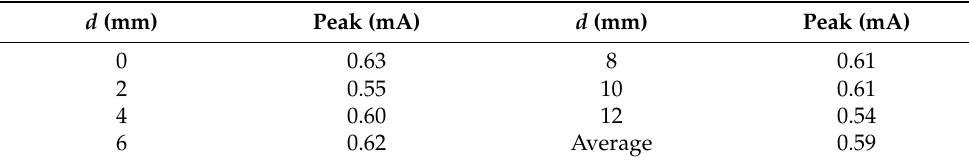
Table 3. The Peak Value of Corona Current for Particle Size = 8